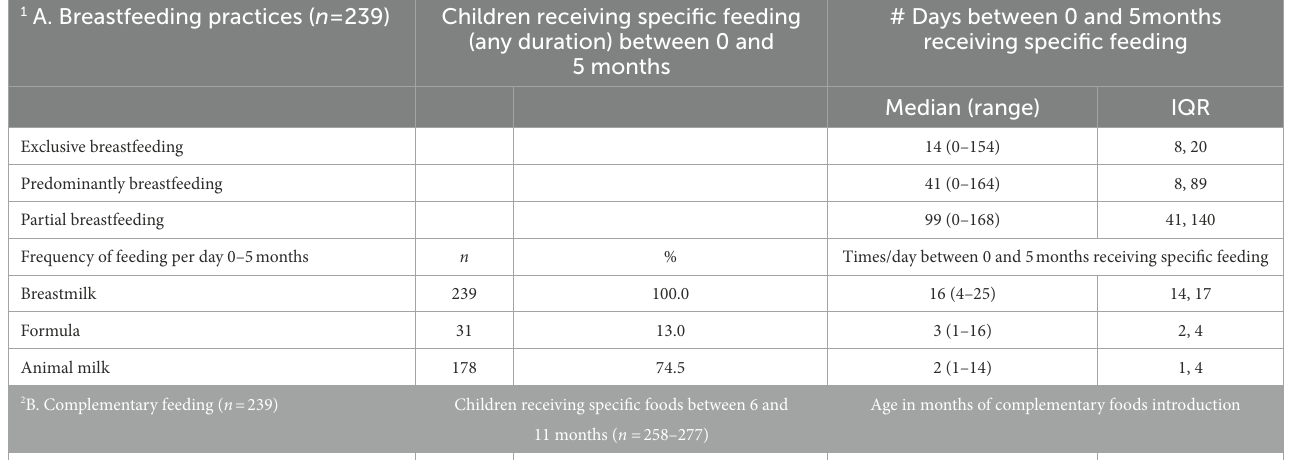
TABLE 2 Feeding practices and infections of Pakistani children during the first year of